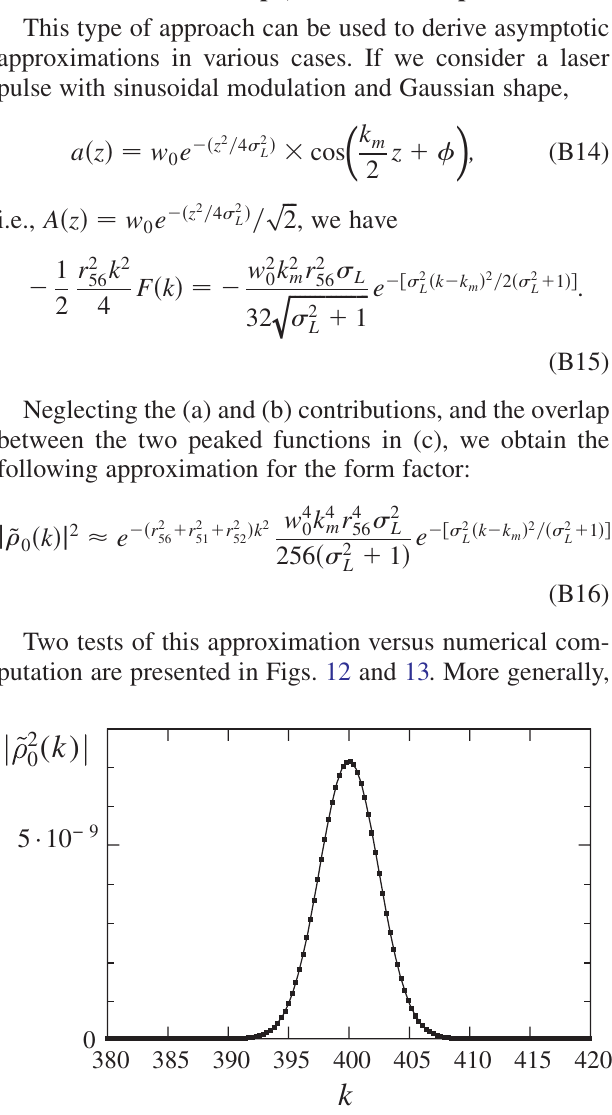
FIG. 13. Form factor in the case of a Gaussian laser pulse with internal modulation: Numerical result from Eq. (A13) (dots) and approximation from Eq. (B16) (full line). k w 0 ¼ 0 : 1 , r 51 ¼ (cid:1) 0 : 000 53 , r 52 ¼ 0 : 0021 , and r 56 ¼ (cid:1) 0 : 0029